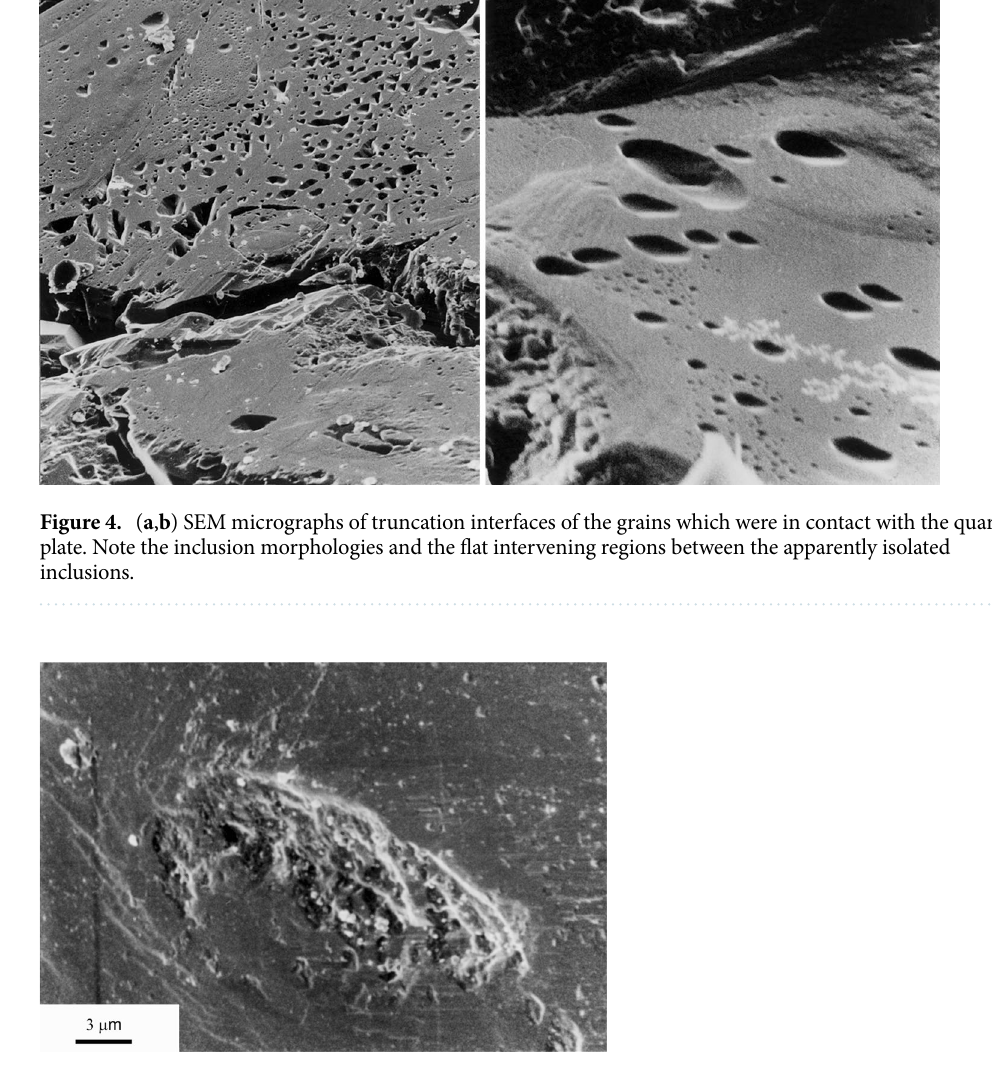
Figure 5. Indentation in the polished crystal face used in test QC13. Only a few of these indentations were observed; most matrix crystals which were in contact with the polished quartz crystal face were truncated without indenting the polished crystal face. Note fine grained debris in and around the pit (inferred to have formed during